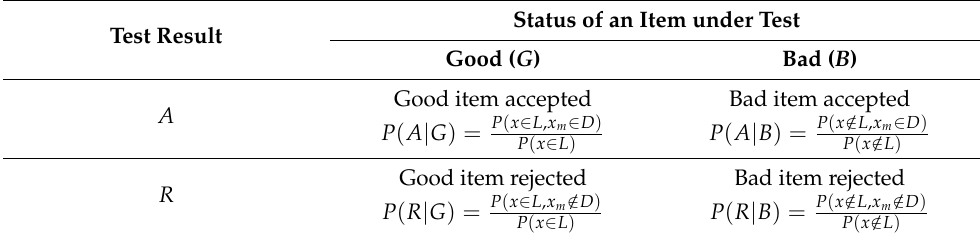
Table 2. Probabilities conditioned on the status of an item under test.